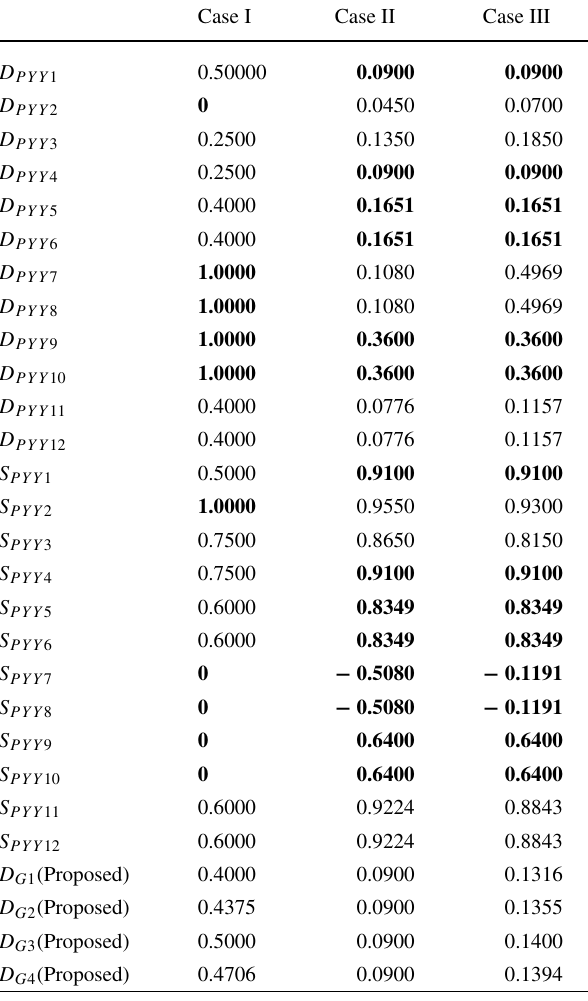
Table 5 Computed values of various PF distance/similarity measures regarding Example 3 Case I Case II Case III